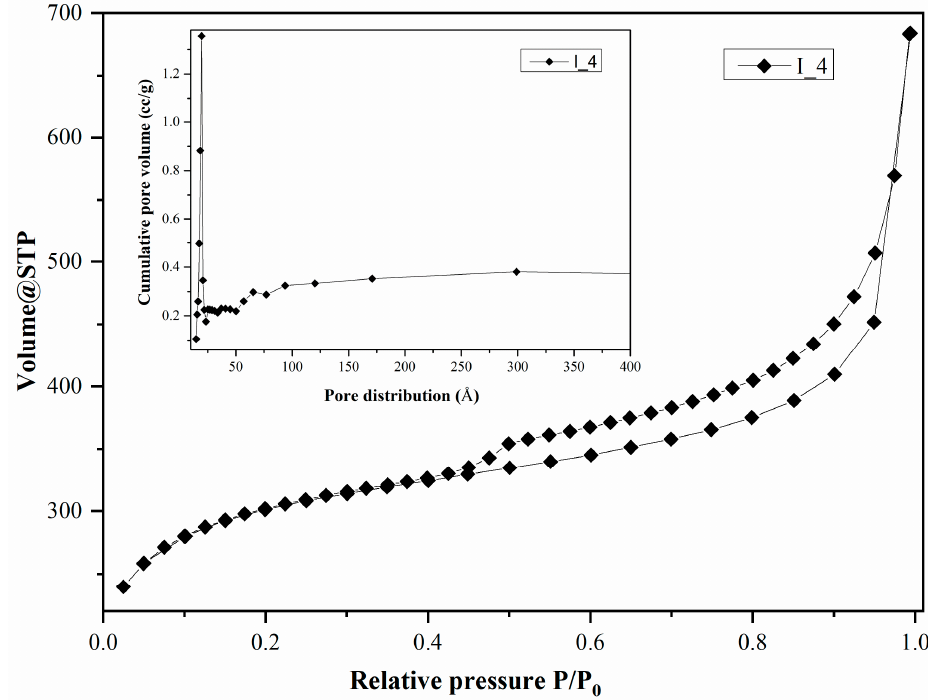
Figure 6. Adsorption isotherms and pore distribution of I_4 sample.